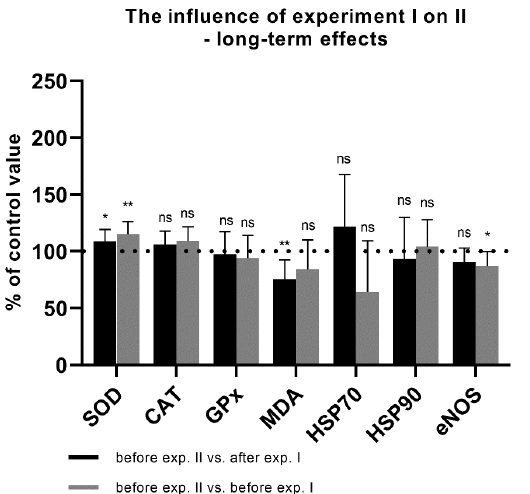
Figure 4. Long-term effects of experiment I. The activity or concentration of biochemical parameters before the exposure of 60 m in relation to the values before and after the first experiment I (exposure of 30 m) (* p < 0.05, ** p < 0.01, ns = p > 0.05).